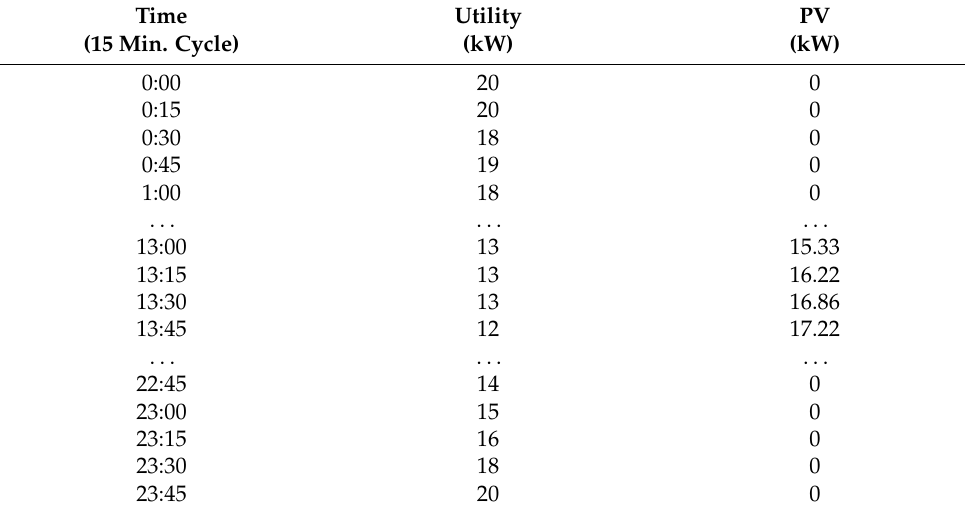
Table 5. Utility grid power supply and PV street generation in Case 4